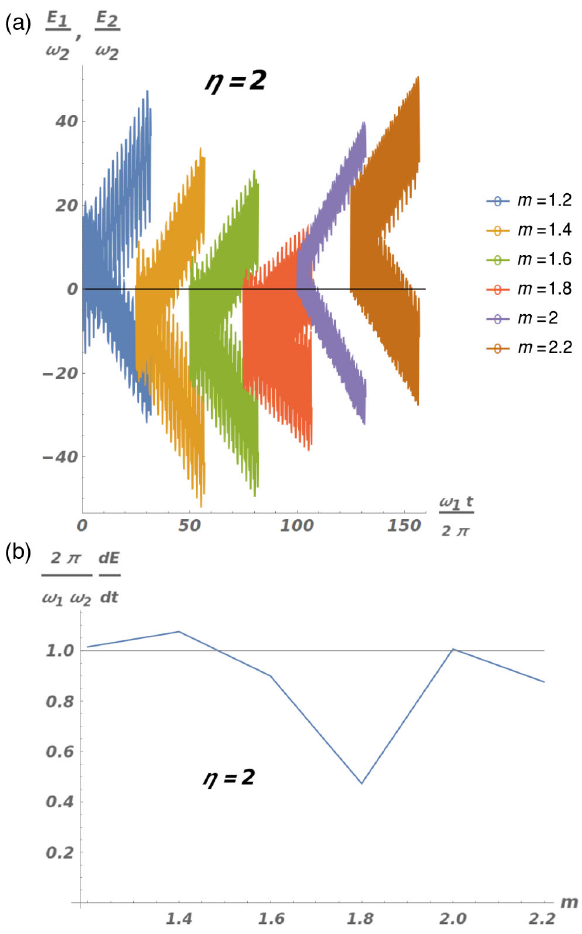
FIG. 7. Pumping profile for different offset phases for ω 3 = 2 Þ ω 2 ¼ ð 1 . (a) Accumulated work for Floquet initial states. (b) Average power for t < 2000 . We take m ¼ 1 , η ¼ 1 , and ϕ 1 ¼ n π = 5 with n ¼ 0 , 1, 2, 3, 4. The Floquet zone path of this system for one offset phase combination is shown in Fig. 3. Floquet eigenstate initial conditions were used. For these parameters, there were no significant differences with instantaneous eigen- state initialization. Here, too, ω 1 ω 2 = 2 π ¼ 0 . 002387